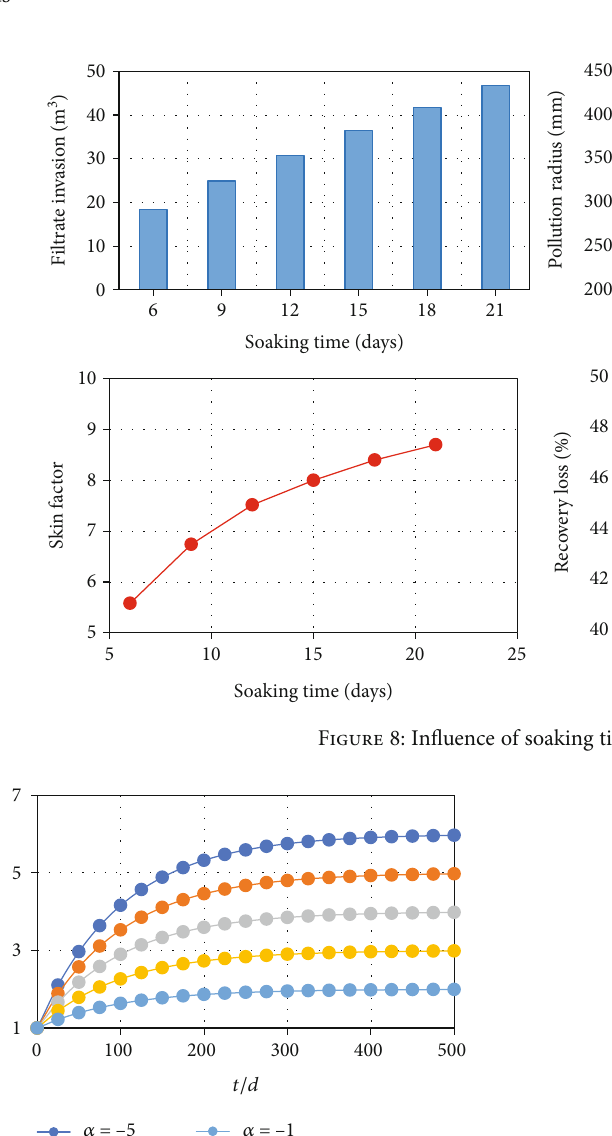
V i at 0.010 D-1.